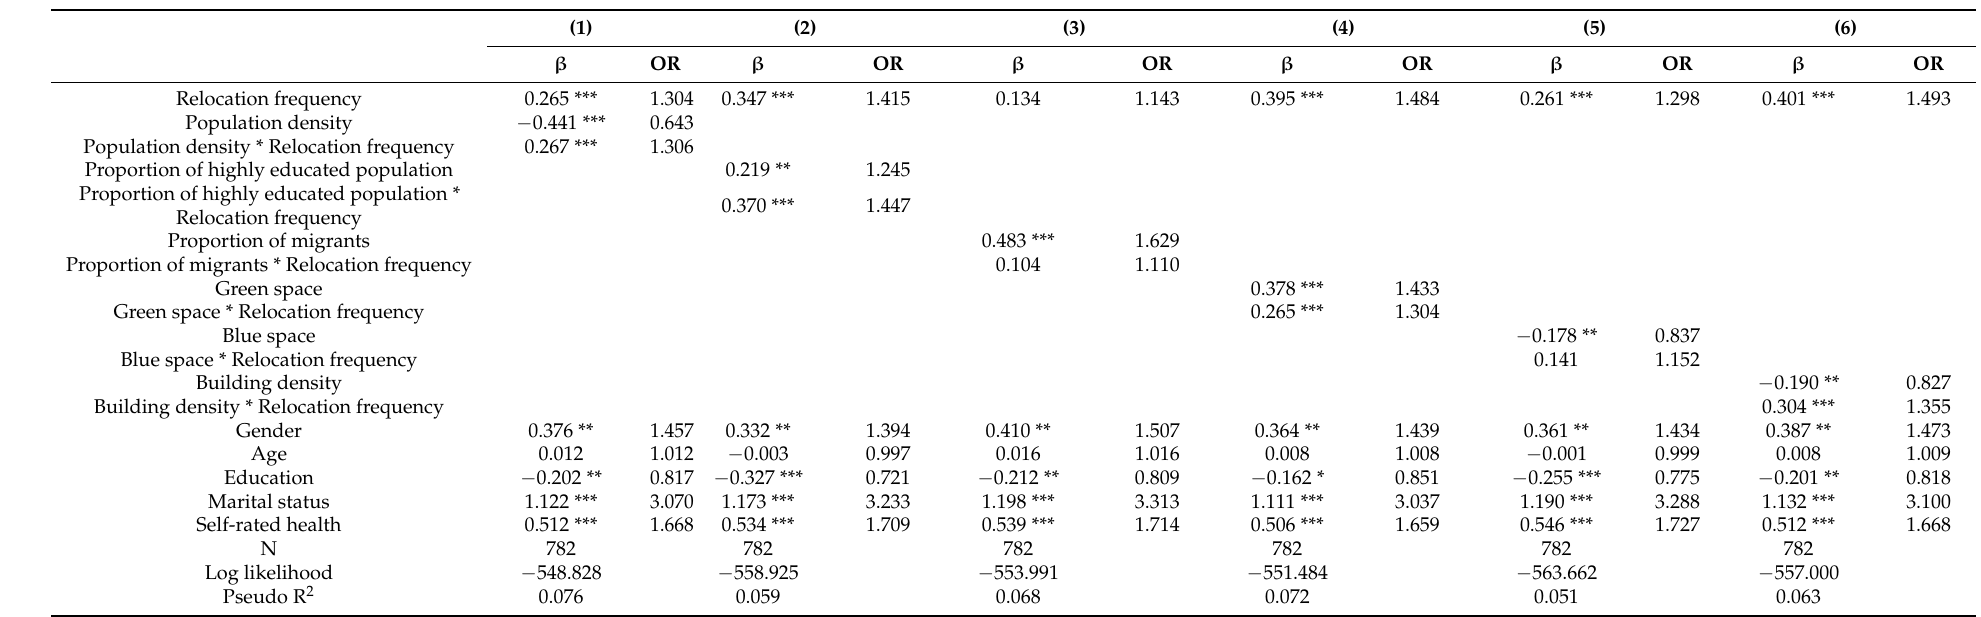
Table 3. Moderating effect of relocation